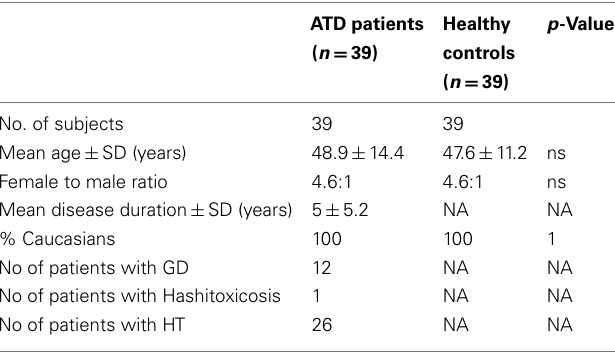
Table 1 | Demographic characteristics of the study